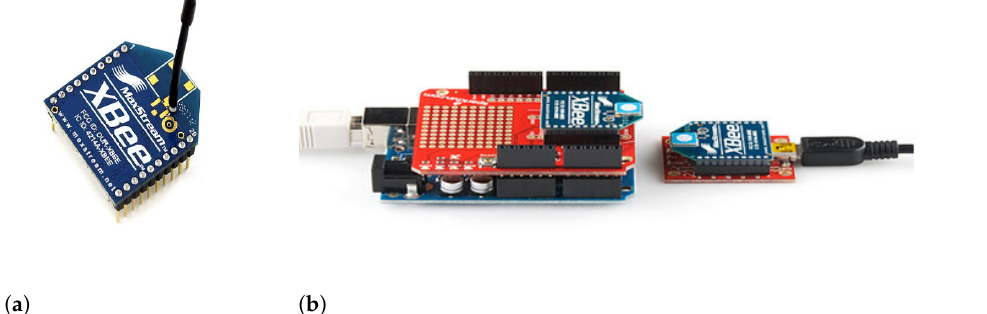
Figure 4. ( a ) XBee S2 wireless module, ( b ) shows how it can be connected to the microcontroller via a shield mounted on top of the microcontroller (on the middle left) or using a gateway (on the right). Table 2. XBee S2 technical specifications XBee-PRO datasheet